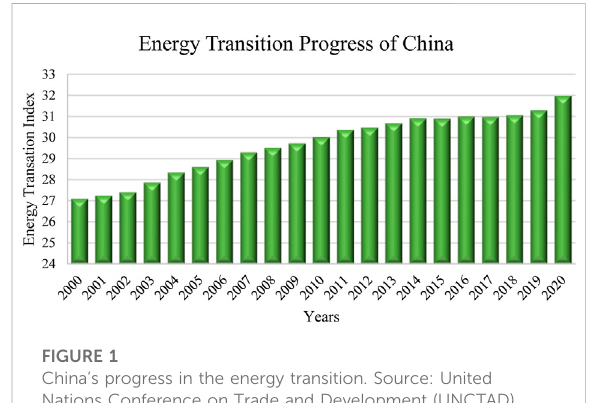
FIGURE 1 China ’ s progress in the energy transition. Source: United Nations Conference on Trade and Development